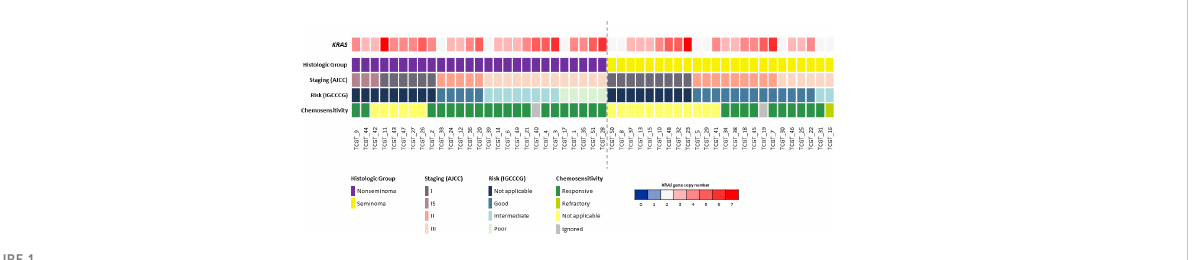
FIGURE 1 Copy number variations of the KRAS gene compared to clinicopathologic data (histological group, staging, risk and chemosensitivity). Only TGCTs evaluated for copy number variation are presented (n = 51). Each column represents an individual patient. The dotted line in the center of the fi gure separates seminoma and non-seminoma cases. A color scale (blue to red) is used to represent the variation in the number of copies of the KRAS gene, in which the dark blue color represents the deletion of two copies of this gene (0 copies); light blue the deletion of only one copy; white represents that there is no loss or gain of copies; and light red to dark red colors represent a gain of copies of this gene (1 to 7 copies).